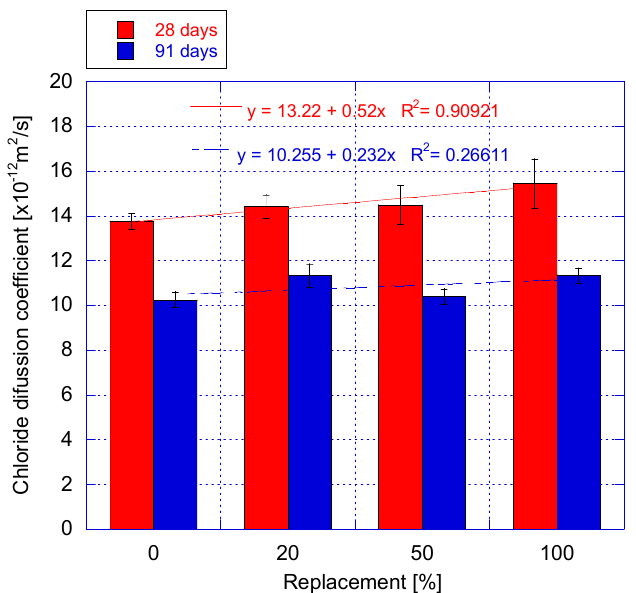
Figure 10. Chloride diffusion coefficient for all mixes and ages.